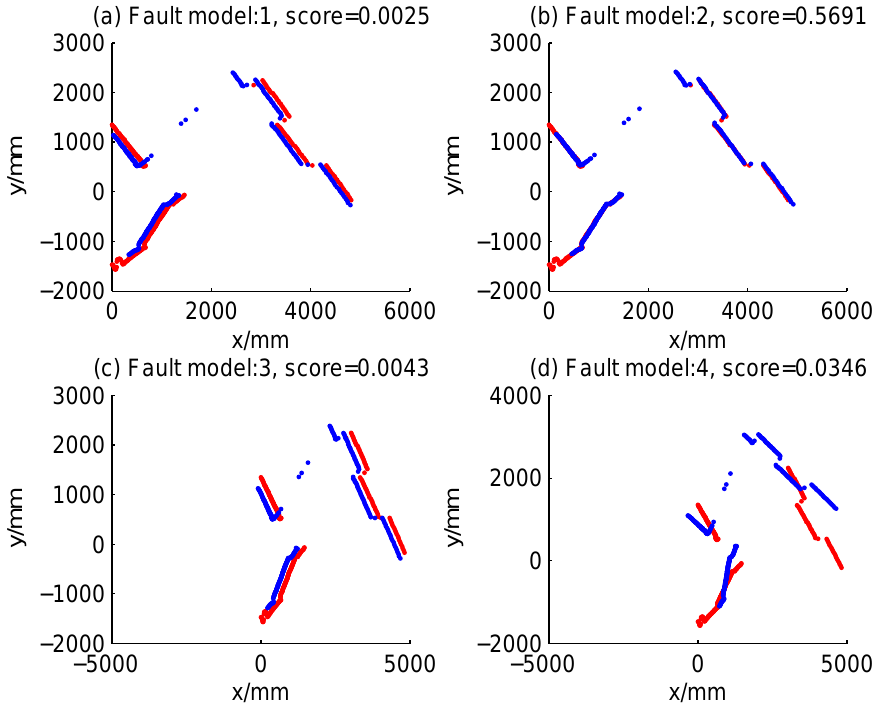
Figure 13. Case 2a: Left encoder stuck, fault model = 2 (time Step